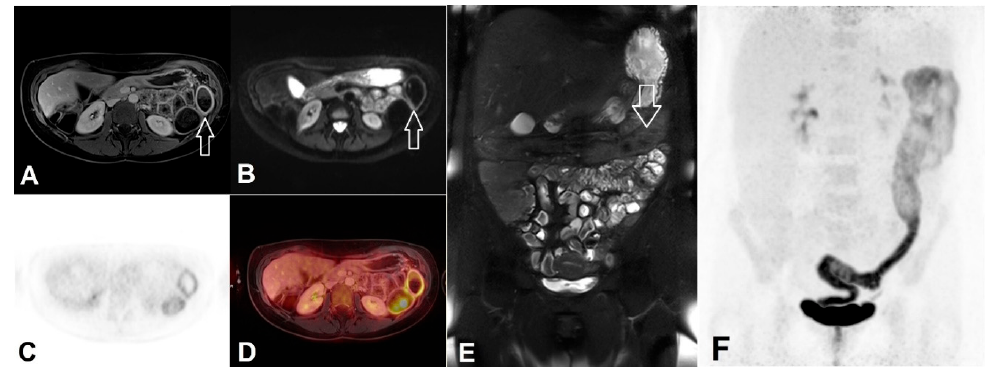
Figure 3. Left-sided colitis in a female patient without previous bowel purgation. Despite feces in colon, left-sided colitis could be found in all PET/MR modalities as well in the ileocolonoscopy. ( A ) Intensive mucosal enhancement of contrast agent in left colon (white arrow) in T1w-3D-VIBE with fat saturation, ( B ) Hyperintensity of bowel wall shown in the b 1000 s/mm 2 of DWI, ( C ) PET, ( D ) Fused imaging of PET and MR, ( E ) Feces in the left-sided colon (white arrow) shown in the fat-saturated T2w HAST ( F ) Maximum intensity projection of PET demonstrating increased tracer uptake throughout the left-sided colon.